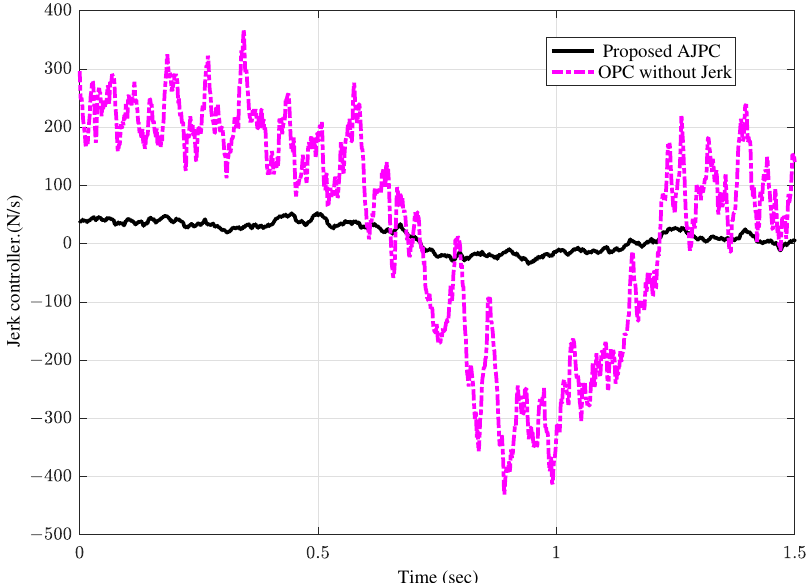
Figure 13. Time domain response of control jerk to an asphalt road using proposed AJPC strategy and OPC strategy without jerk.